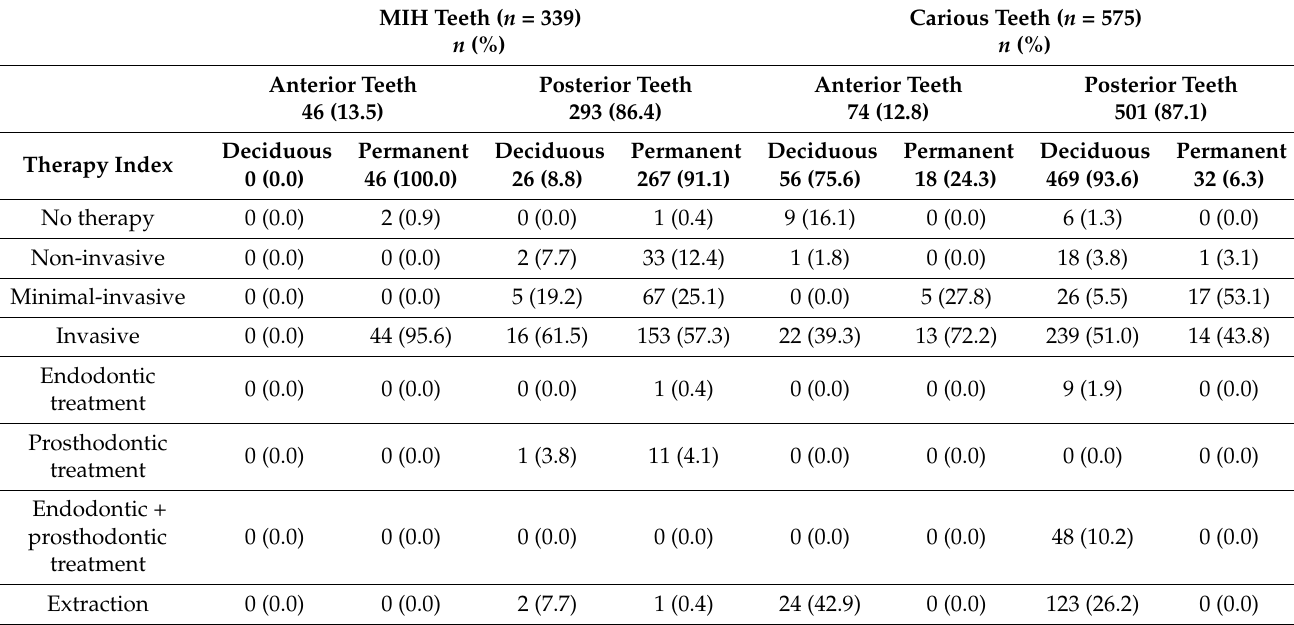
Table 2. Affected and Treated Teeth in MIH and Caries Group.